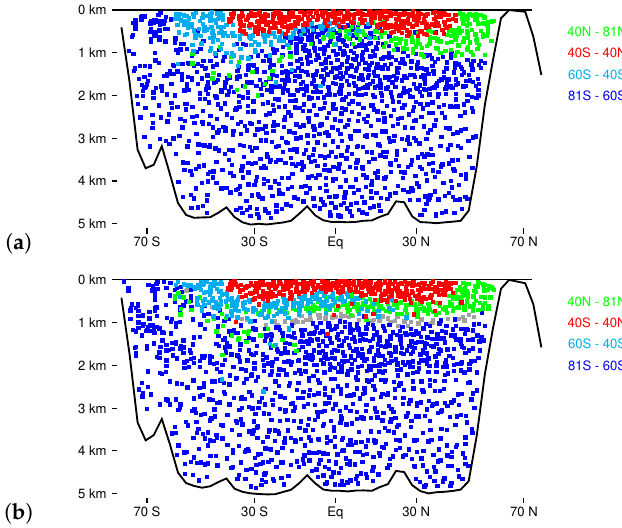
Figure 14. Water masses along 170 ◦ W. Parcels are color coded by the latitude of last surface contact in ( a ) the simulation with mixing, and ( b ) the simulation without